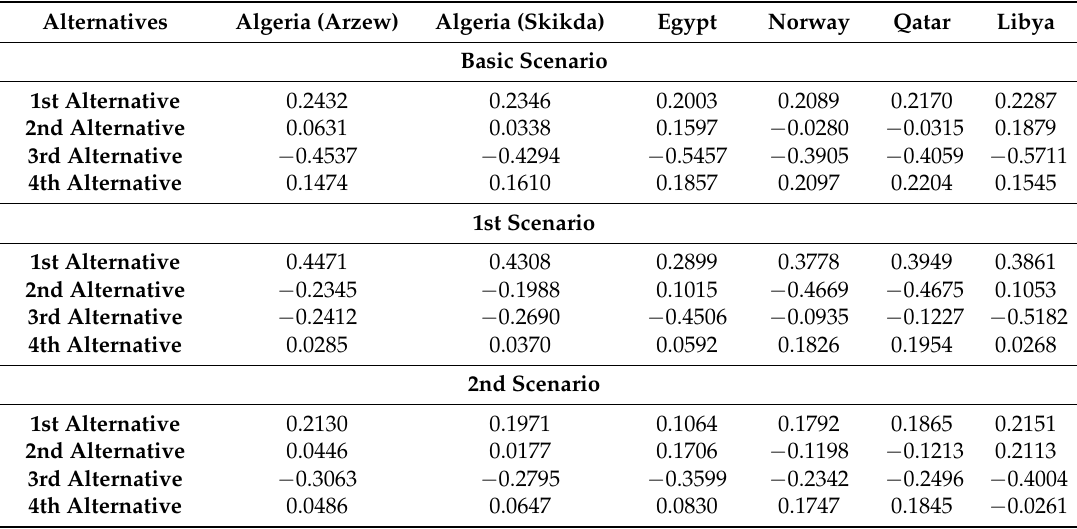
Table A1. The values from the calculation of Net Flow ( Φ ).